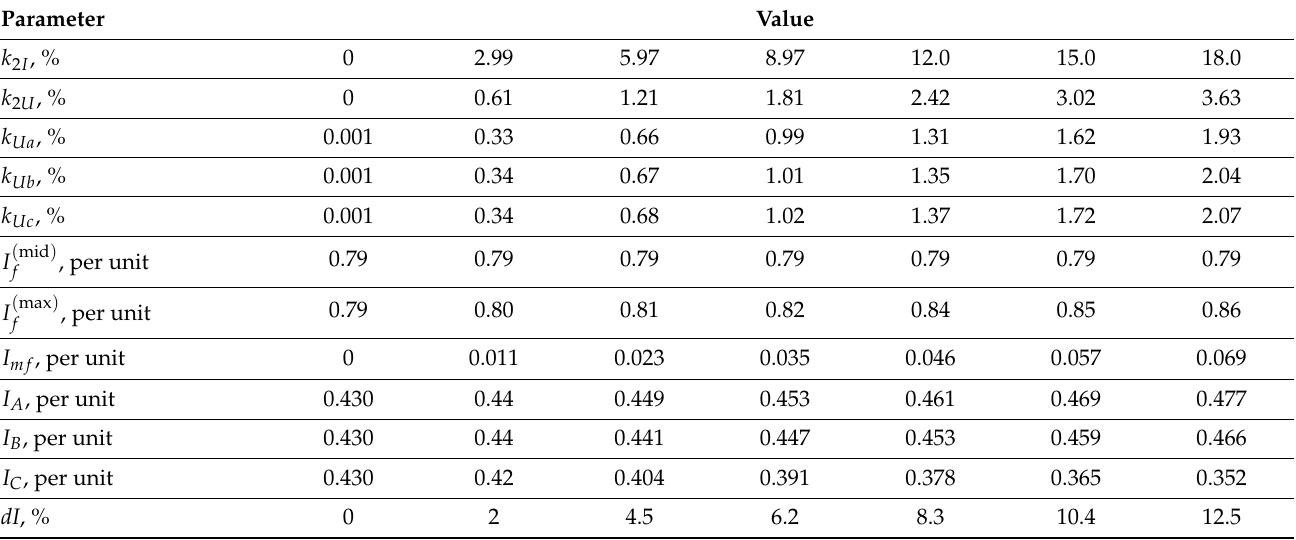
Table 2. Experimental data for the case of the generator model in MATLAB serving a unbalanced load.